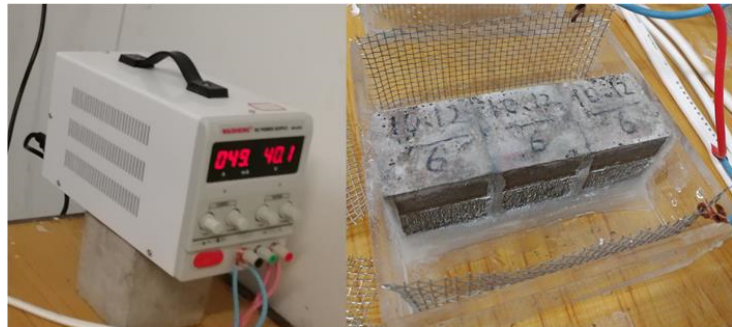
Figure 3. Physical map of stray current device.